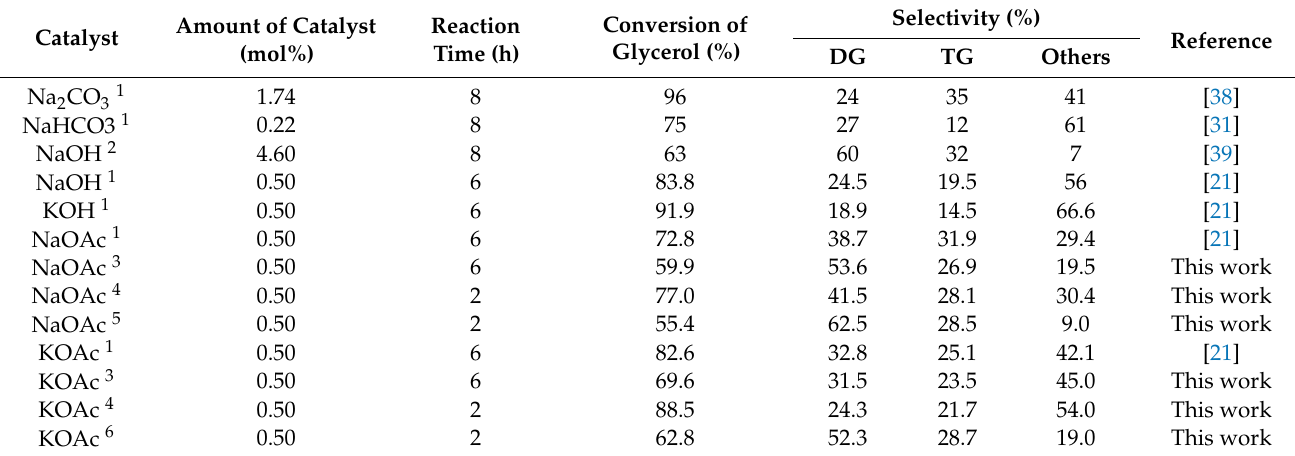
Table 1. Etherification reactions of glycerol with basic